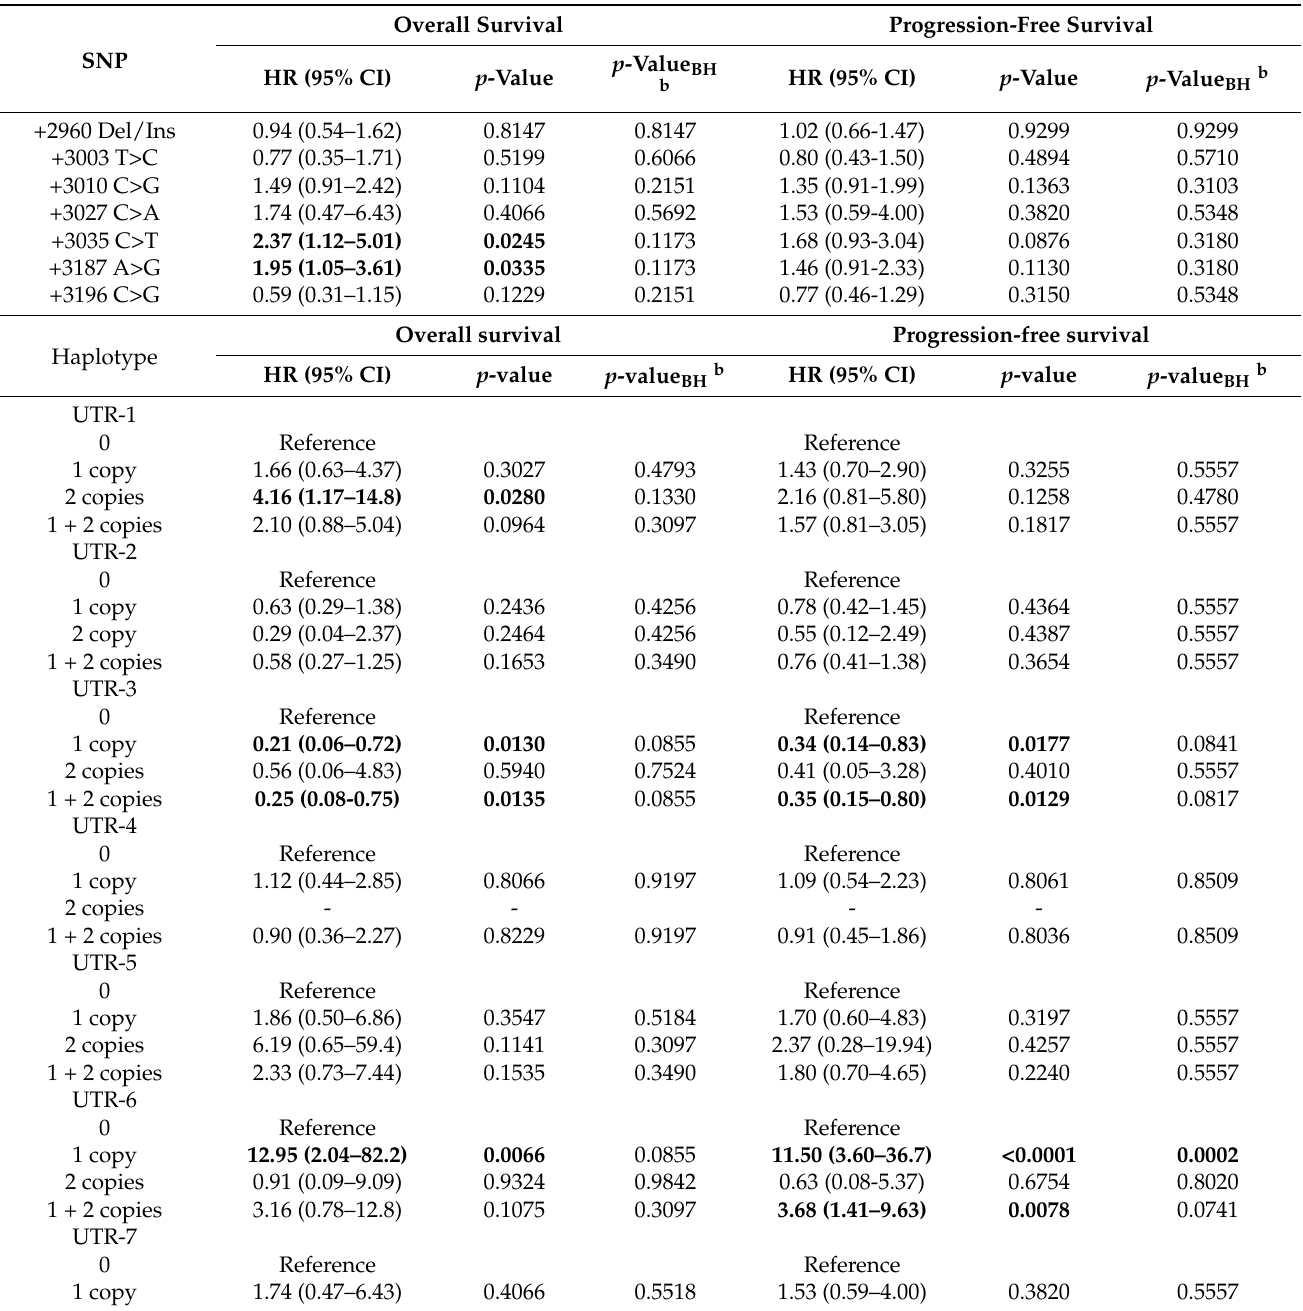
Table 4. Multivariable hazard ratio (HR) and corresponding 95% confidence intervals (CI) a for death or progression according to HLA-G 3 (cid:48) UTR polymorphisms (additive model) and to the most frequent haplotypes in patients with complete or partial